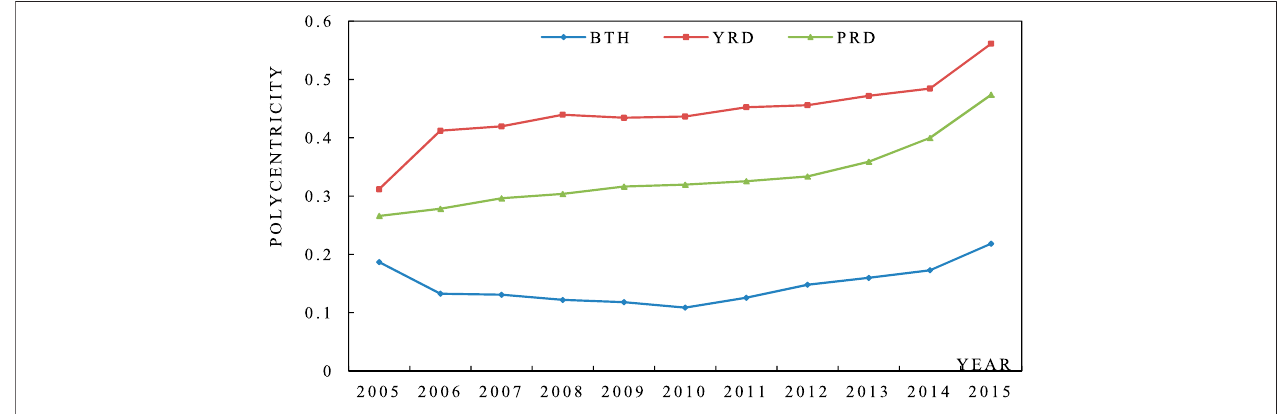
FIGURE 4 | Functional polycentricity evolution of three